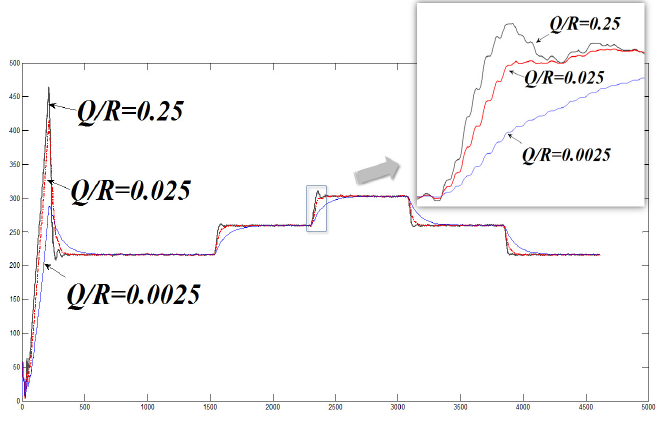
Figure 12. Estimated magnitude of the fundamental component: TV Kalman filter with various Q / R .